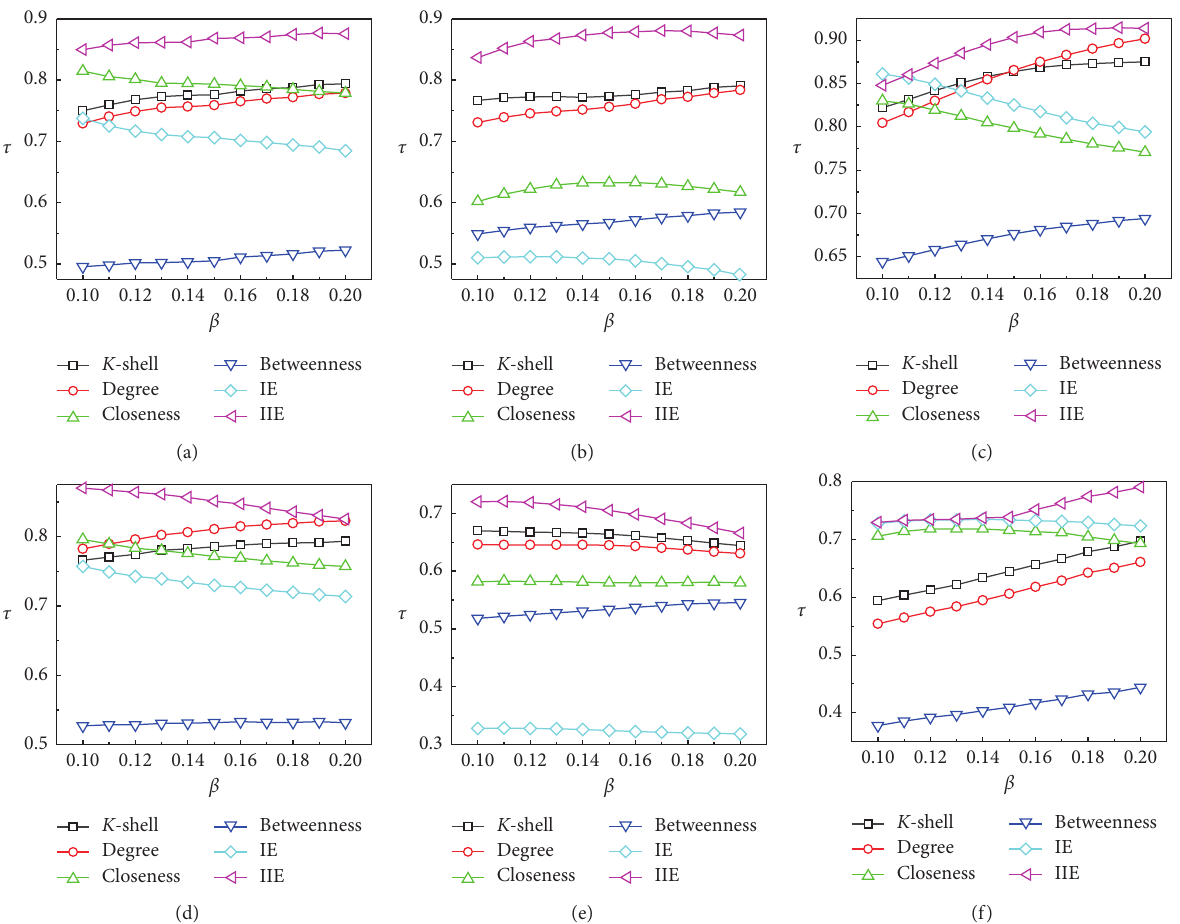
Figure 4: (Color online) The figure shows a comparison between the ranking list produced by the SIR model, and the ranking lists produced by the K -shell, degree centrality, closeness centrality, betweenness centrality, IE method, and IIE method lead to Kendall’s Tau τ . We set β ∈ [ 0 . 1 , 0 . 2 ] and μ � 1. Each data point is calculated from the average of 10 3 experiments. (a) US air. (b) Polblogs. (c) E-mail. (d) Soc- hamsterster. (e) Facebook. (f)